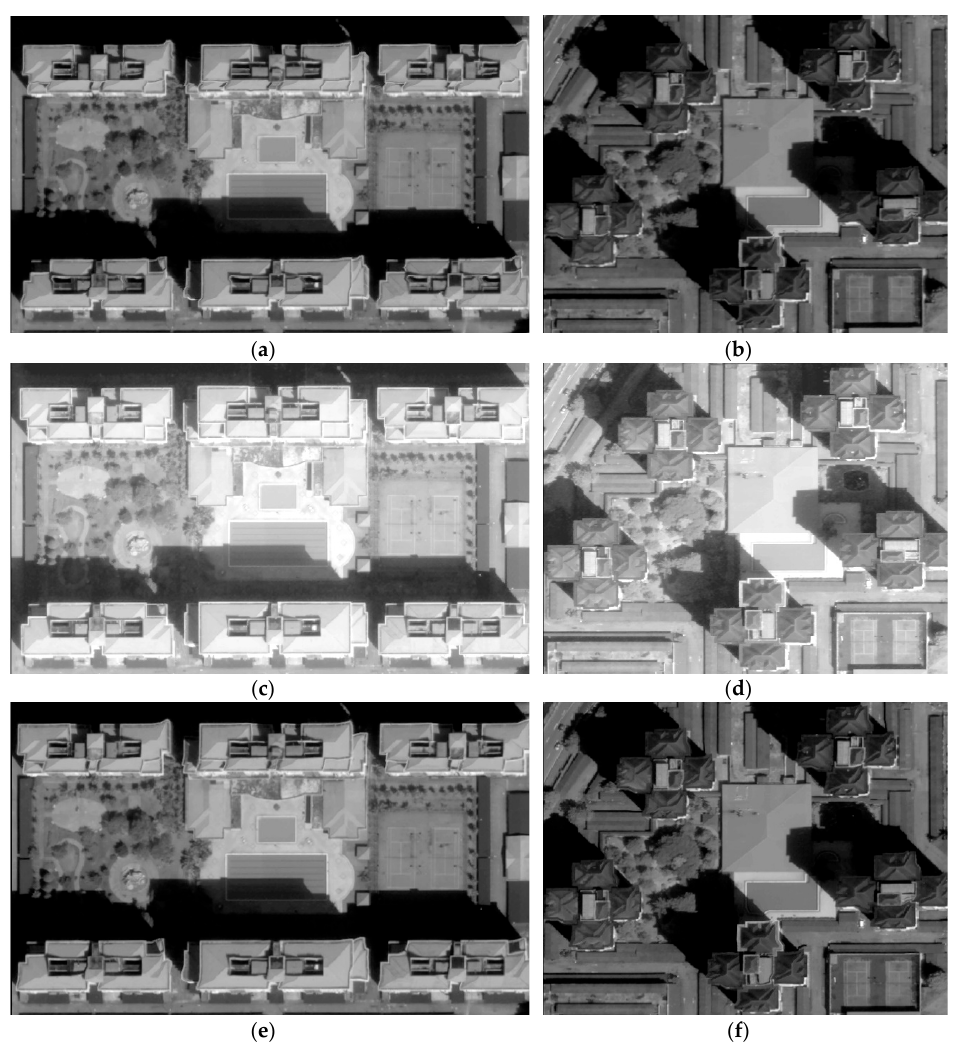
Figure 7. Comparison of different parametric in 3D RCP model: ( a ) BI systematic with 80 GCPs over 75 m building, ( b ) BI systematic with 125 GCPs over 85 m building, ( c ) CC convenience with 80 GCPs over 75 m building, ( d ) CC convenience with 120 GCPs over 85 m building, ( e ) NN systematic with 80 GCPs over 75 m building, ( f ) NN systematic with 125 GCPs over 75 m building.